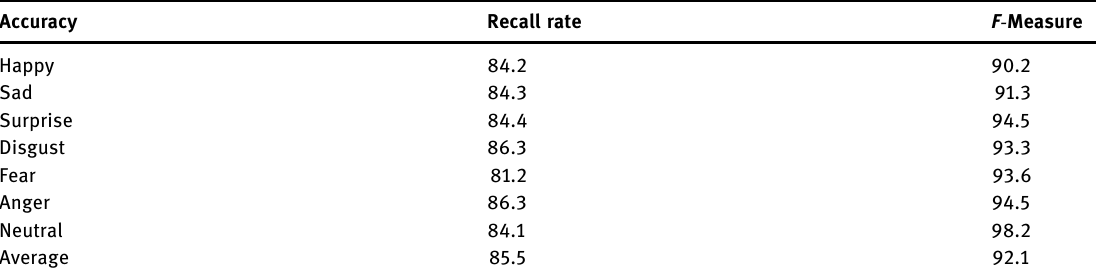
Table 2: The recall and the F